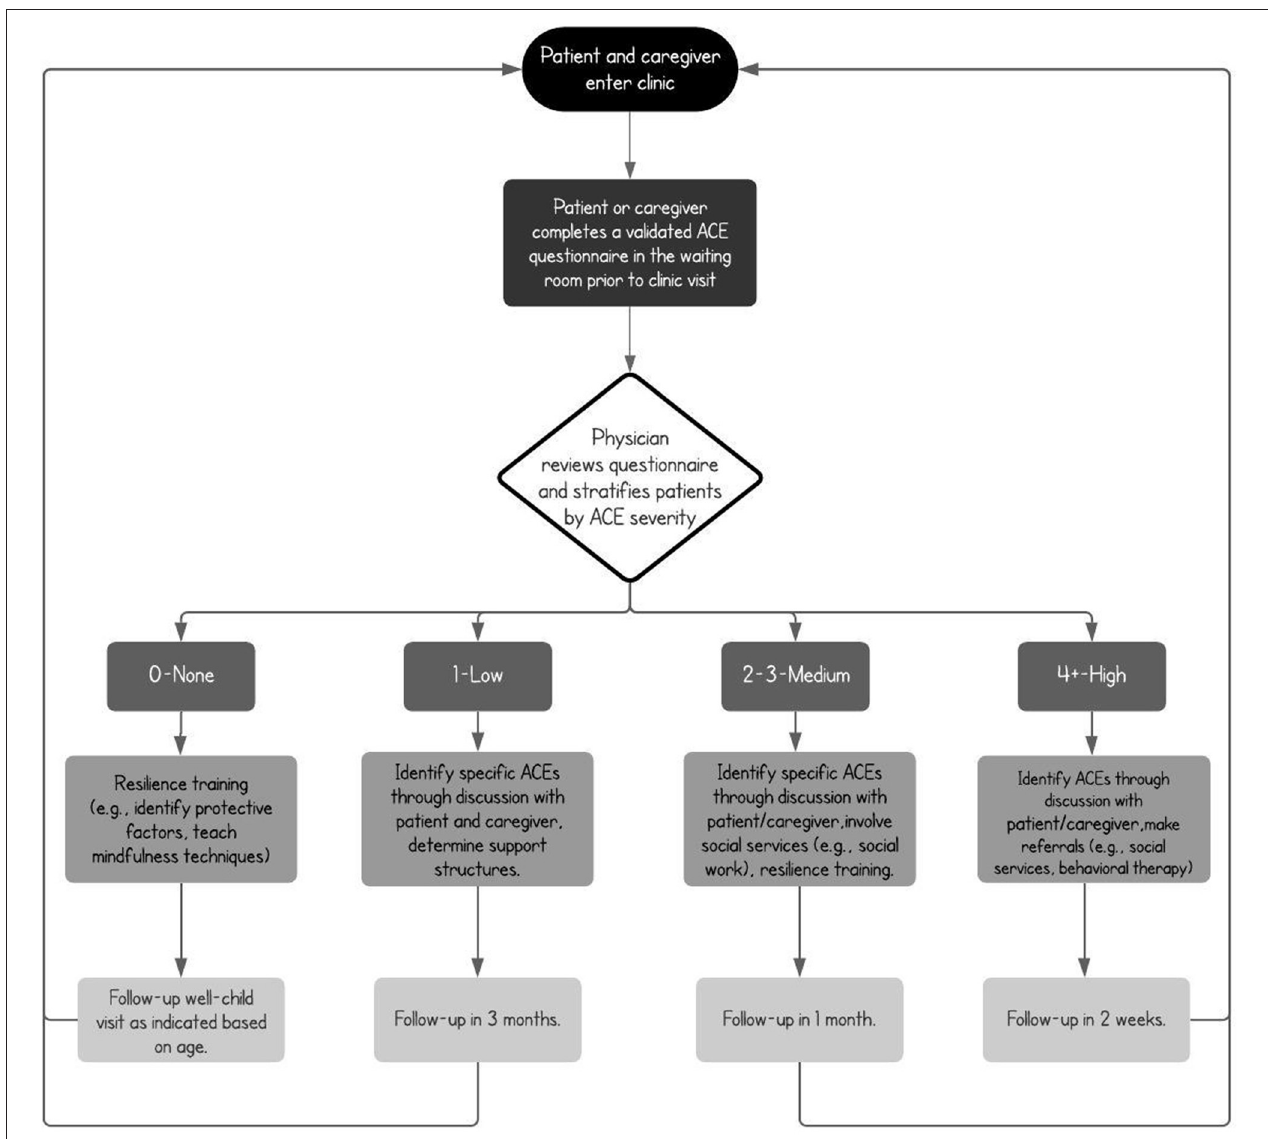
FIGURE 1 | Sample clinical algorithm for ACE assessment, stratification (14), and intervention in the primary care setting, based on validated inventories. At each well-child visit, screening, detection, classification, and mitigation should be undertaken by the physician, with appropriate referrals made and close-follow up scheduled. In cases where no ACEs are found, protective factors should be determined and resilience techniques